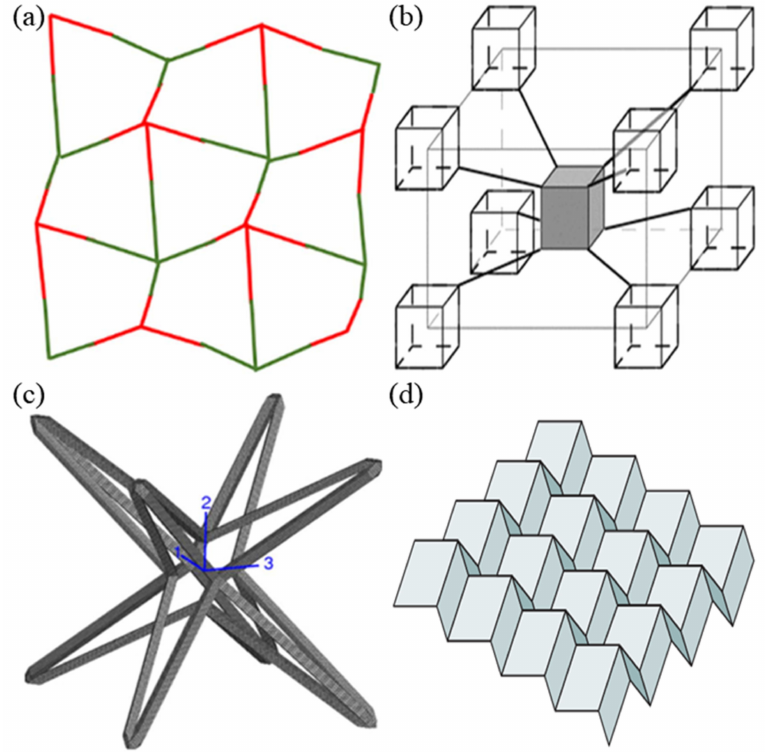
Figure 6. Examples of miscellaneous structure; ( a ) the egg rack model, ( b ) tethered nodule model, ( c ) hexatruss model, and ( d ) origami structure